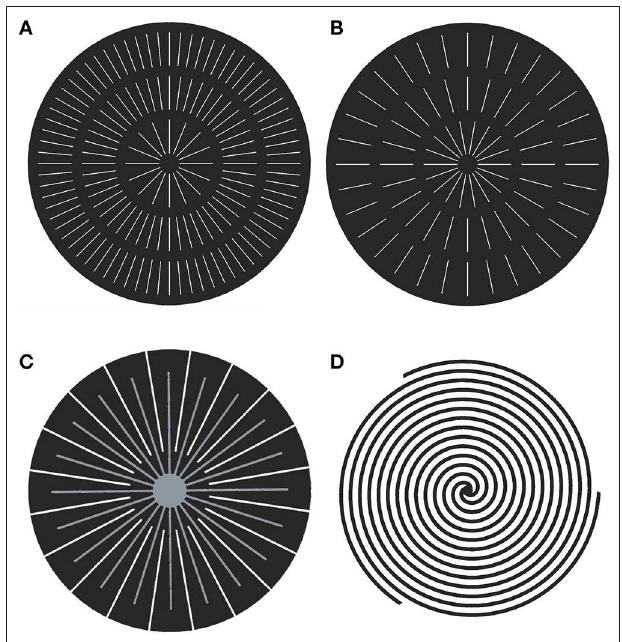
FIGURE 7 | Sketches of radial designs: with 16-48-72 (A) and 18-24-32 (B) radial and 2 circular channels, with 20 pairs of radial interdigitated channels (C) , from Friess and Hoorfar (2012), and 3-channel spiral design (D) , from Juárez-Robles et al. (2008).